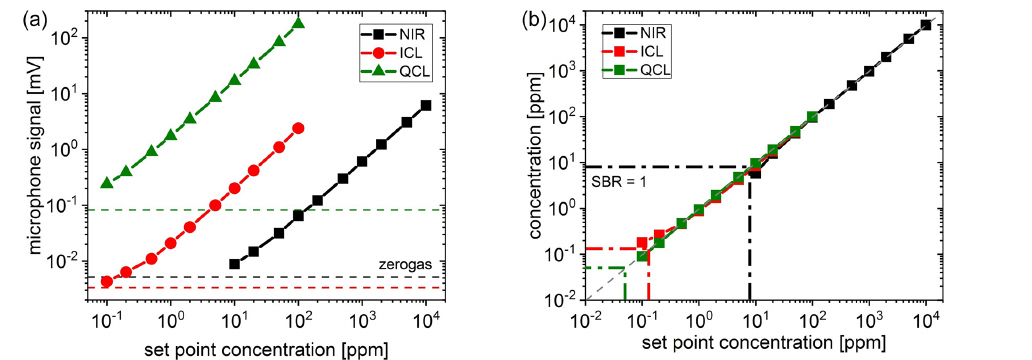
Figure 7. (a) Gas calibration curves of the PAS measurements. The signal levels for zero gas (dry N 2 ) are indicated for the three different lasers NIR, ICL and QCL. (b) Merged calibration curves similar to Fig. 4. LODs corresponding to SBR = 1 are indicated for the three lasers.